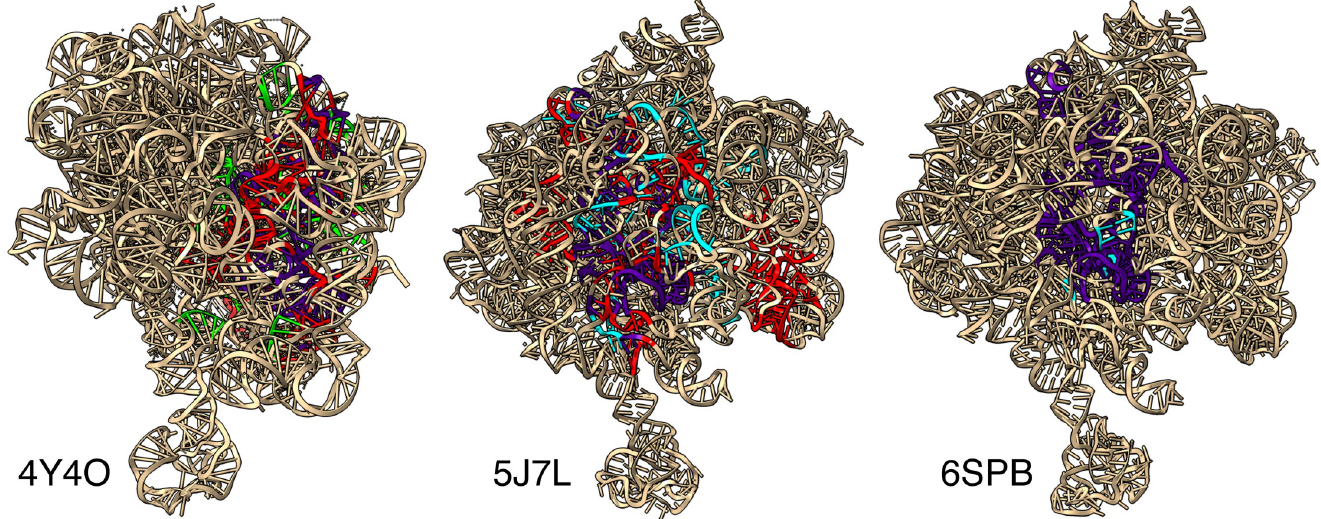
Fig 13. 3 Largest RIN a in their contexts. The figure displays three 3D structures of ribosomal RNAs: 4Y4O (chain: 2A), 5J7L (chain: DA) and 6SPB (chain: A). The s found in Dataset 3.137: RIN a 1984 in red, RIN a #1983 in cyan and RIN a #1982 in lime green. The overlap of two RIN a colored parts correspond to the 3 largest RIN a s colored in indigo. Additional information about those RIN a and their overlap is provided in Table 7. s